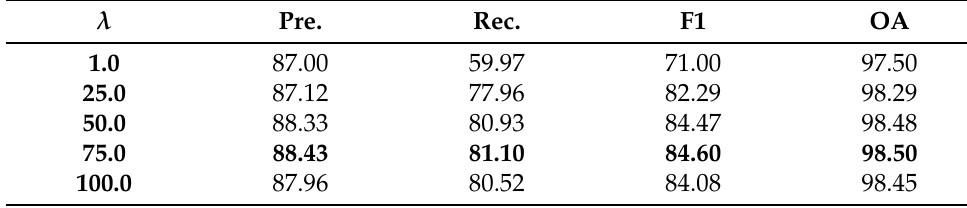
Table 6. Quantitative results of the effect of λ on LEVIR-CD with 4096 pairs images. λ